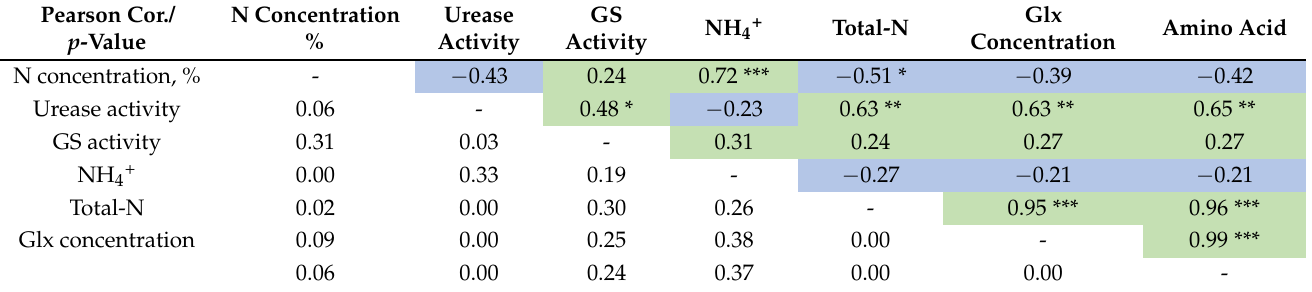
Table 2. Pearson correlation and pairwise correlation t -test ( p -values) of the N-concentration in the applied urea solution with surfactant and the N parameters evaluated in the YFEL of spring wheat (cv. Harenda) at 7